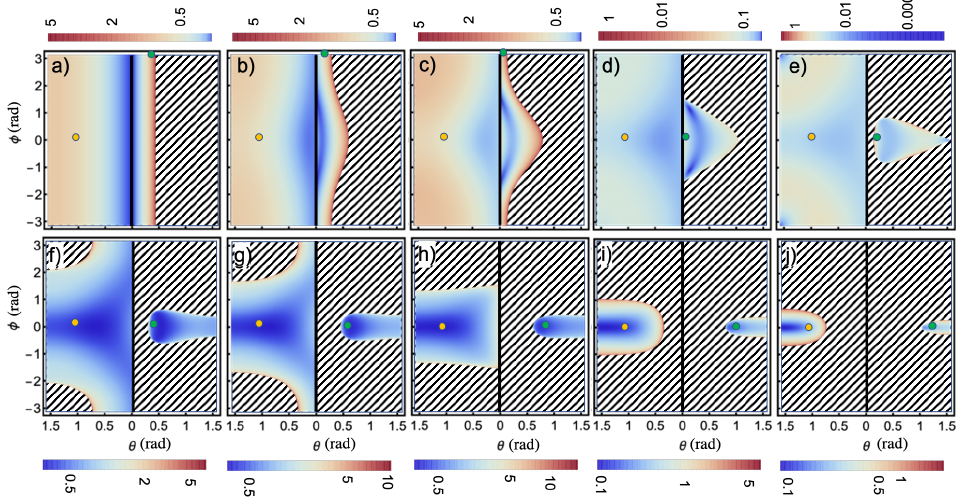
Figure 4. Density polar plots of emitted radiation in TM polarization. Plots correspond to the same momentum kicks as in Figure 3. The shown correlated emission directions (orange and green circles), as well as employed parameters, are the same as in Figure